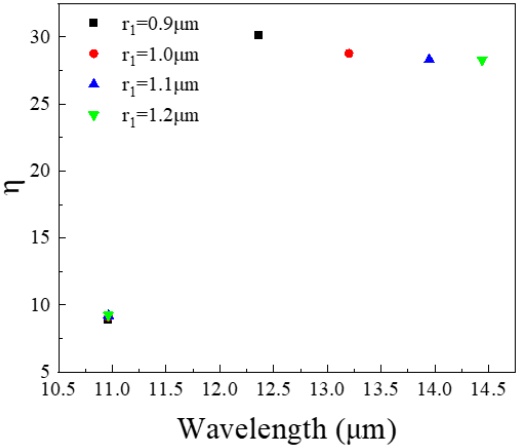
Figure 8. In the wavelength range of 10.5 – 15 μm, the maximum coupling efficiency corresponding to different r 1.